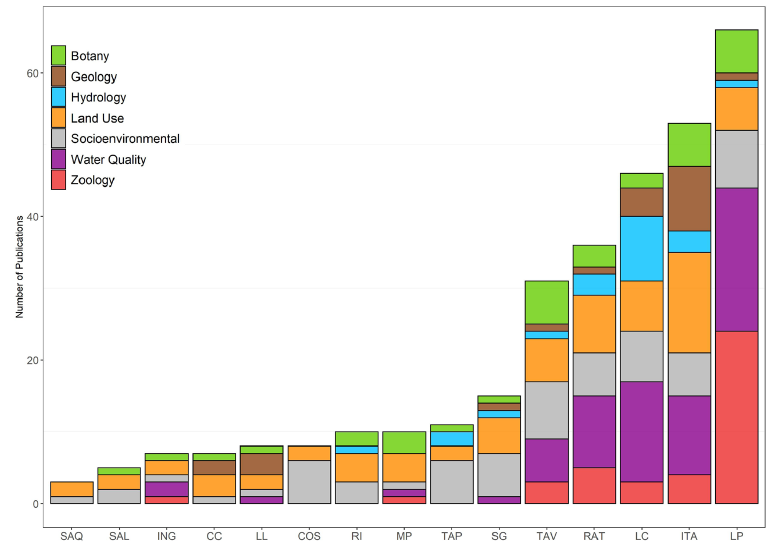
Figure 6. Number (N) of publications on the subjects studied on the seven sub-areas of aquatic ecology in the last three decades by watersheds of Santa Catarina Island (Green = botany; Brown = geology; Blue = hydrology; Orange = land use and land cover; Grey = socio-environmental; Purple = water quality; and Red = zoology), (SAQ = Saquinho; SAL = Santo Antônio de Lisboa; ING = Ingleses; CC = Cacupé; LL = Lagoinha do Leste; COS = Costeira; RI = Ribeira da Ilha; MP = Morro das Pedras; TAP = Tapera; SG = Saco Grande; TAV = Rio Tavares; RAT = Ratones; LC = Lagoa da Conceição; ITA = Itacorubi; and LP = Lagoa do